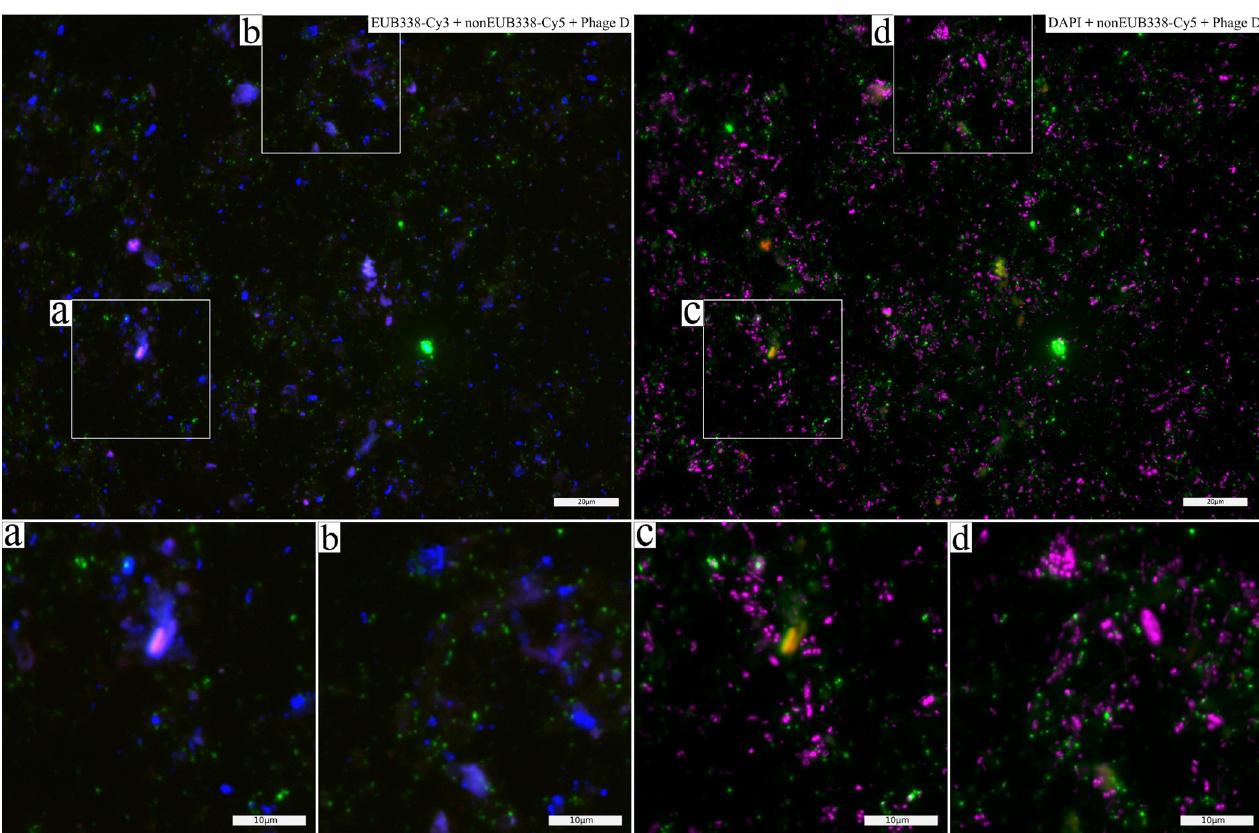
Fig 2. Co-localisation of phage signals to EUB338-Cy3 and DAPI signals. Microscopic image of faecal smear (sample F95) hybridised with bacterial probe EUB338-Cy3 (blue, only shown in a and b), and phage group D probes (signal simplified—green), and non-specific probe nonEUB338-Cy5 (negative control— red). All nucleic acids stained with DAPI (magenta, only shown in c and d). Co-localisation with phage signals is better observed with DAPI staining than with the bacterial probe EUB338-Cy3. Scale bars indicate 20 μ m and 10 μ m